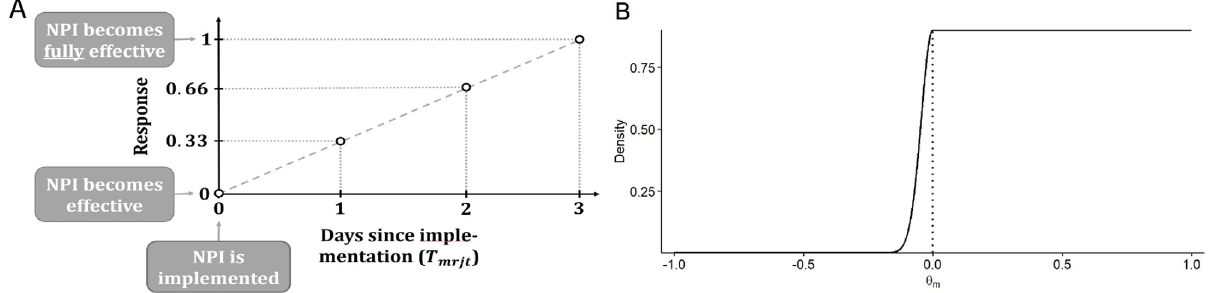
Fig 3. Modeling choices for the effects of NPIs. (A) Time-delayed response function as a first-order spline. (B) Prior for the effects of NPIs θ m .